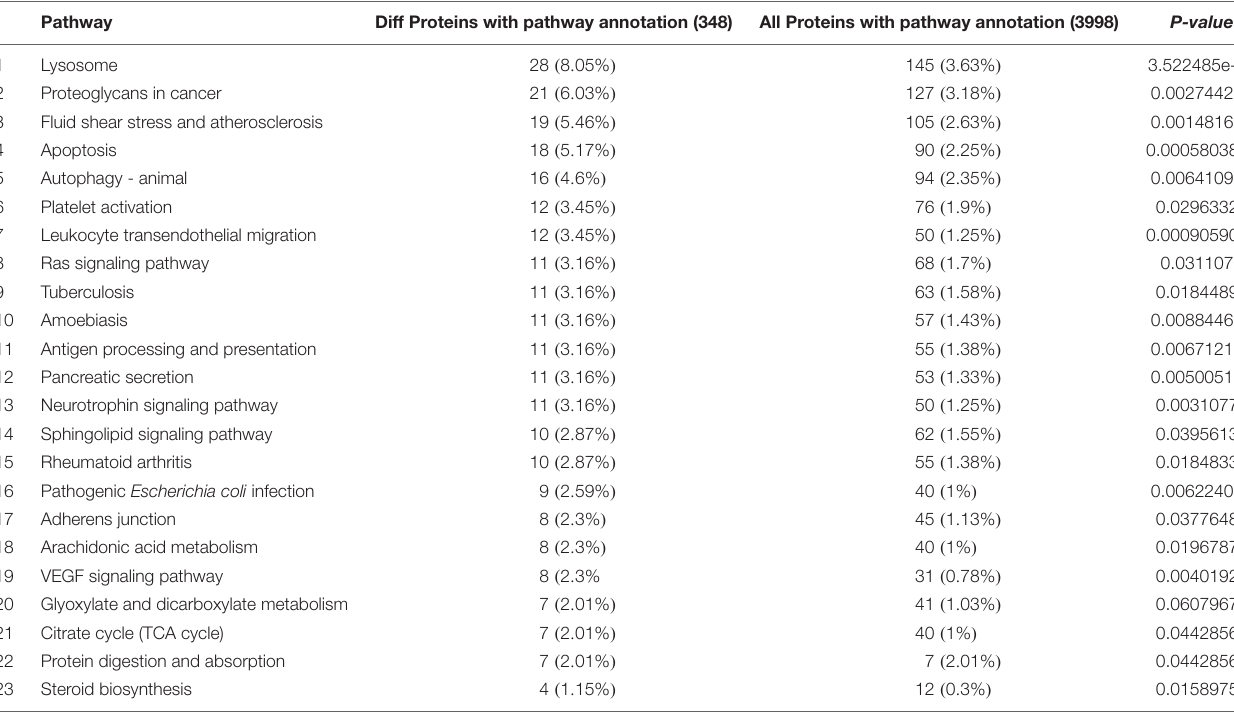
TABLE 3 | Significantly enriched KEGG pathways in the proteome.